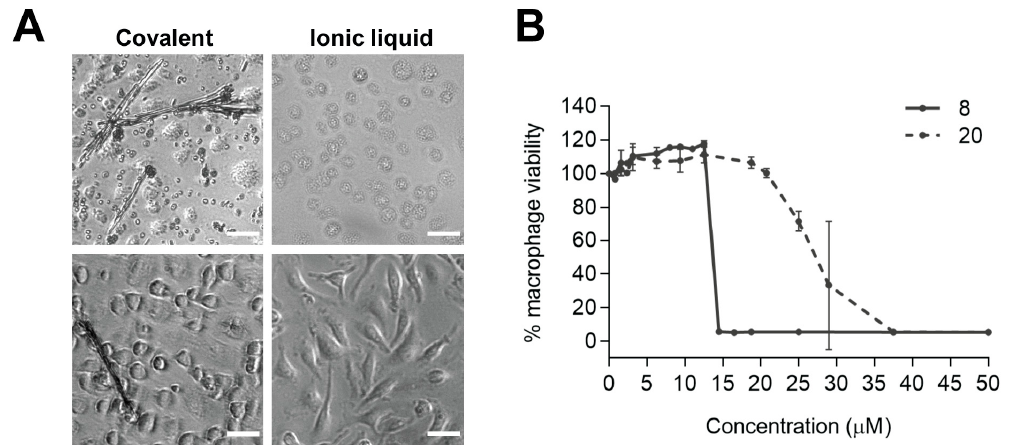
Figure 10. ( A ) Representative bright field images (Leica DMI6000 microscope, scale bar 30 μ m) of BALB/c mice bone marrow-derived macrophages (BMM) incubated with either a covalent chloroquine-CA conjugate 8 (n = 4, R = p -Me)—left, or its surrogate ionic liquid 20 —right, at 100 μ M (upper panel) or at 12.5 ( 8 ) and 18.75 ( 20 ) μ M (lower panel). ( B ) Cytotoxicity for BMM was determined in parallel by the resazurin reduction assay (average ± SD) in three independent experiments. The abrupt decrease in macrophage viability above 12.5 μ M is probably related to the crystallization of the compound observed for 8 , and not for 20 [97].